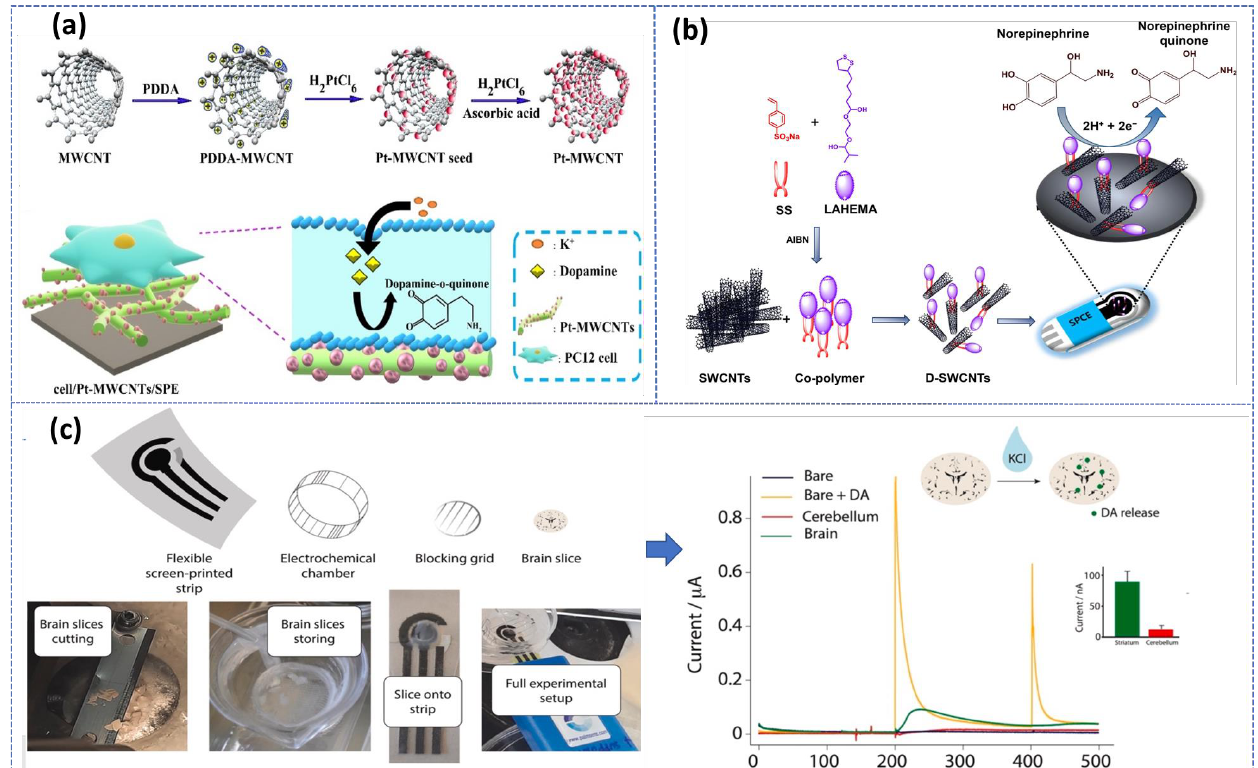
Figure 4. Ex vivo electrochemical biosensors based SPE: ( a ) Monitoring of DA secreted from PC 12 cells using Pt nanoparticle decorated CNTs. Reproduced with permission from [73]. Copyright 2023, Elsevier, ( b ) Schematic illustration of NE quantification in rat tissue samples based on Co − Polymer and SWCNTs. Reproduced with permission from [74]. Copyright 2023. Elsevier, and ( c ) experimental setup of DA detection released in mice brain using unmodified SPE and its corresponding chronoam- perometric measurements with different configurations for striatum cerebellum brain slices before and after 0.1 M KCl stimulation. Reproduced with permission from